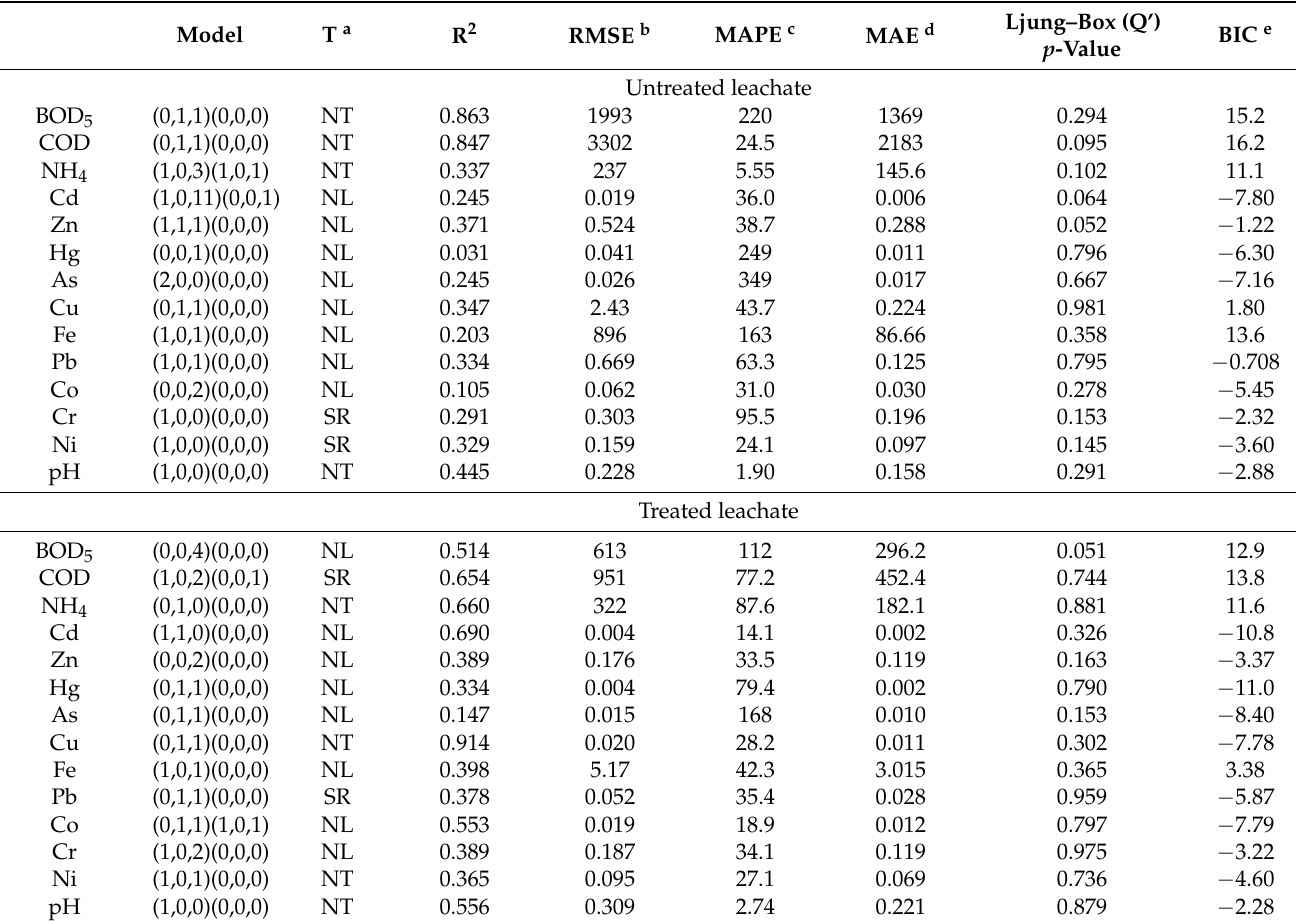
Table 2. ARIMA models for the chemical parameters of untreated and treated